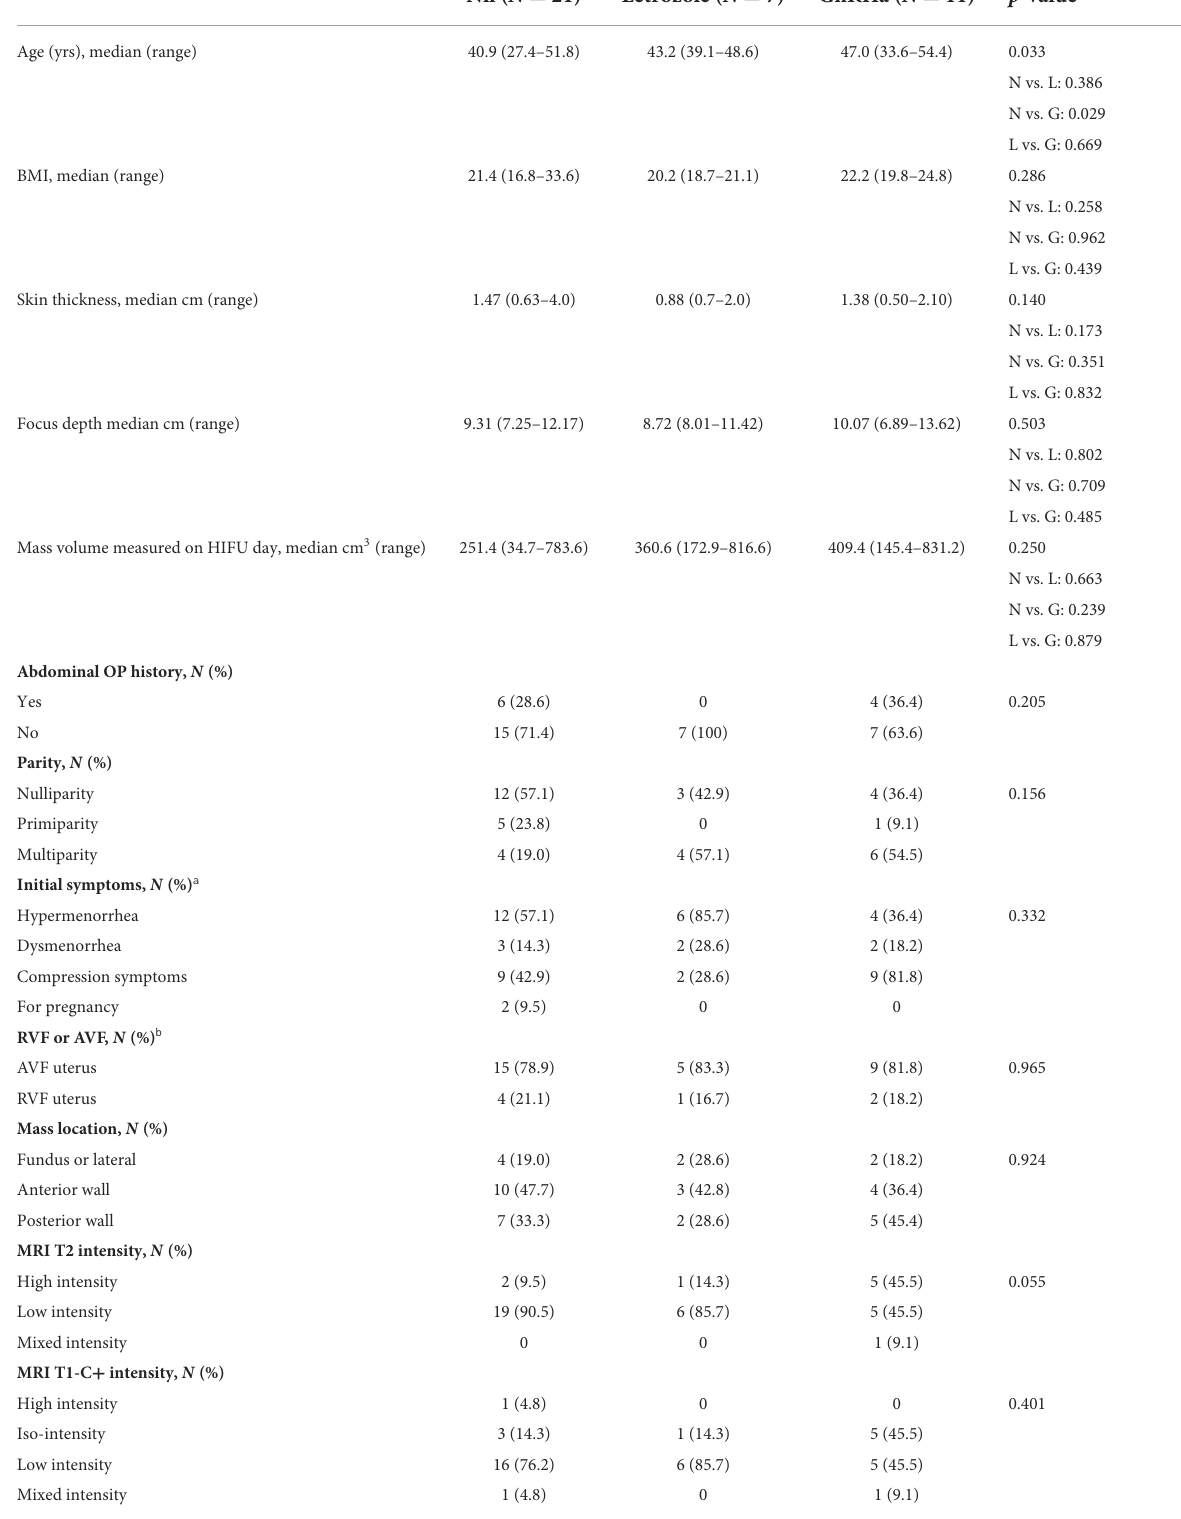
TABLE 1 Patient